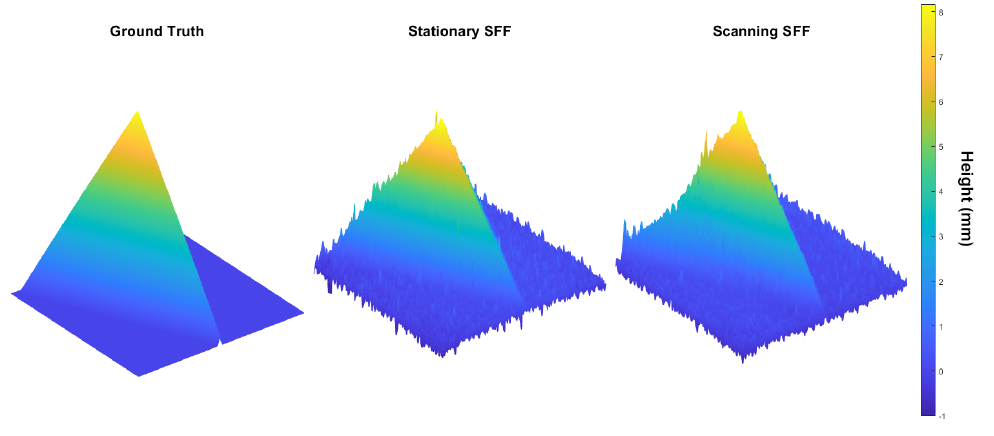
Figure 8. Depth -map of the CAD design of the PCT and the recovered depth-maps using the stationary SFF method and the proposed scanning SFF